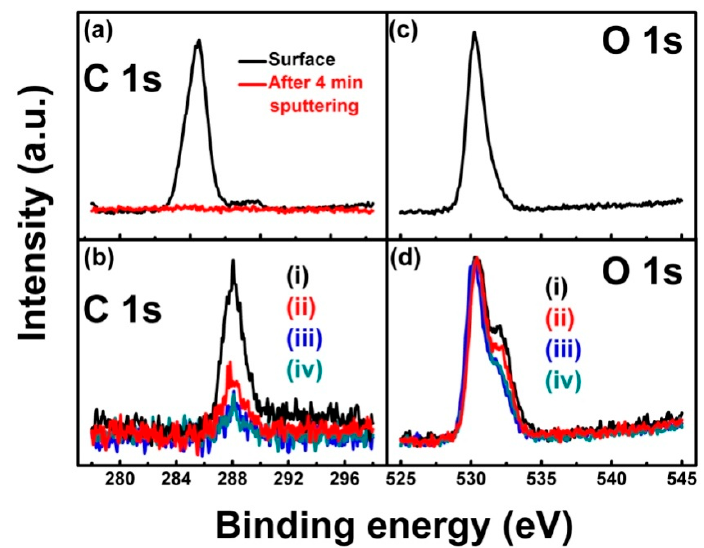
 beam bombardment; Figure 5. High-resolution XPS spectrum. ( a ) C 1 s for ITO film (i) before CH x ( b ) C 1 s for ITO films (i) to (iv) bombarded by CH + x beam, after 4 min of Ar + cleaning; ( c ) O 1 s for ITO  beam, after 4 min of Ar  cleaning; ( c ) O 1 s for ( b ) C 1 s for ITO films (i) to (iv) bombarded by CH film (i) before CH + x beam bombardment, after 4 min of Ar + cleaning and ( d ) O 1 s for ITO films (i) to x  beam bombardment, after 4 min of Ar  cleaning and ( d ) O 1 s for ITO (iv) bombarded by CH + x beam, after 4 min of Ar + ITO film (i) before CH x  beam, after 4 min of Ar  cleaning. films (i) to (iv) bombarded by CH x